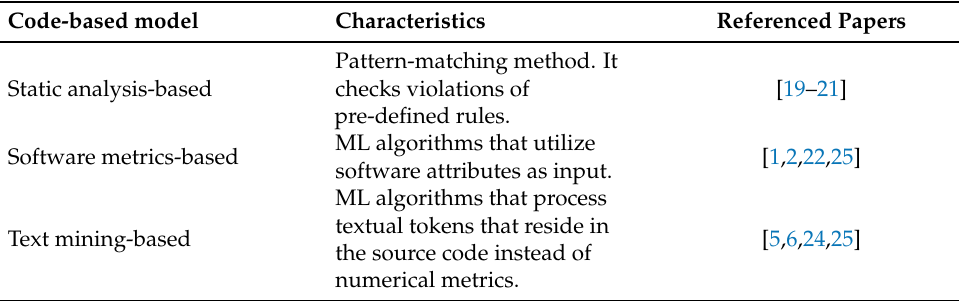
Table 1. Code-based models’ discrete